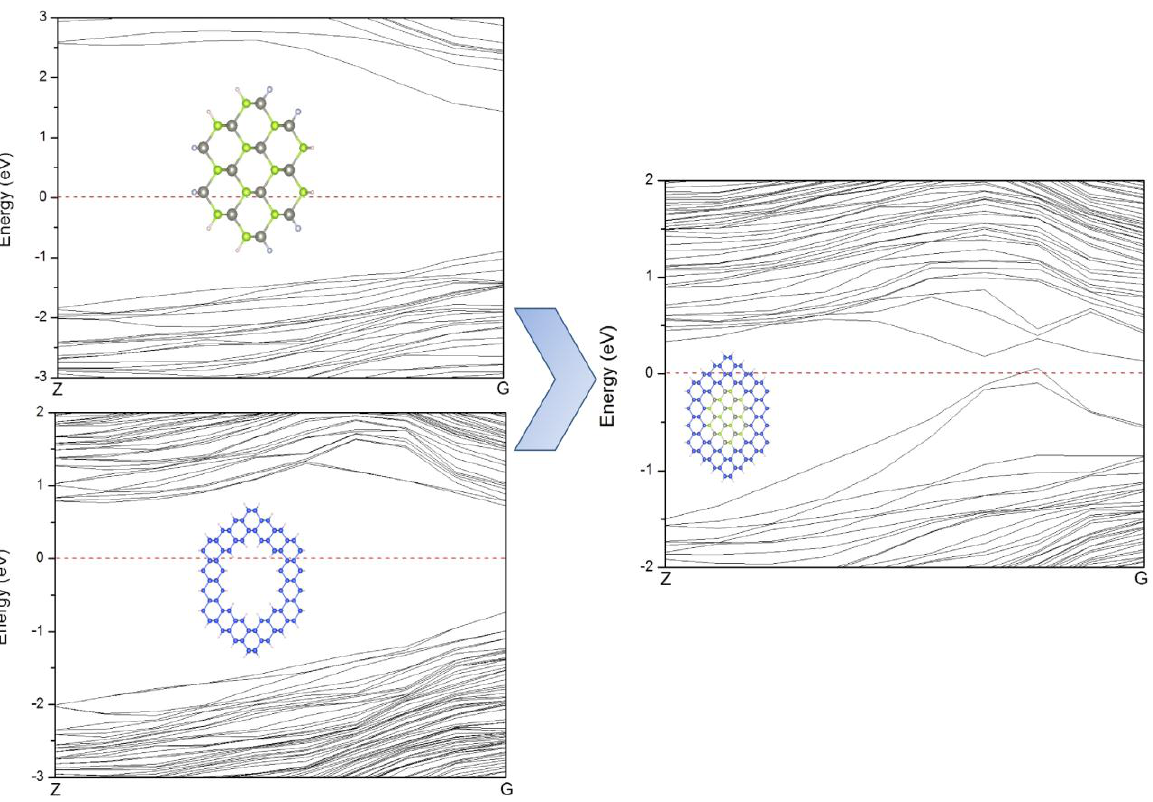
Figure 8. The band structures of ZnSe NWs W1, NTs N2 and ZnSe-core (2.5, 0.25) NWs, which can be considered to be composed of W1 and